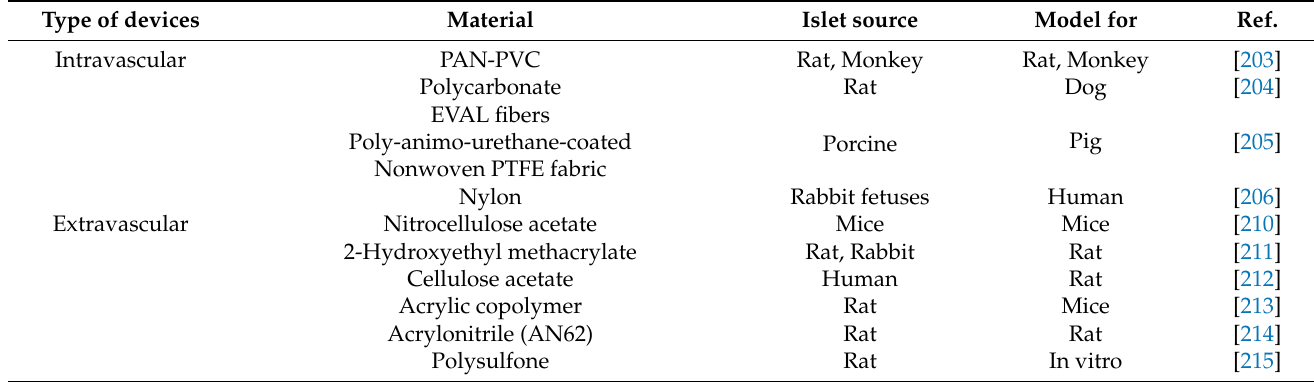
Table 6. Polymeric membranes were applied for intra/extravascular microencapsulation devices. Type of